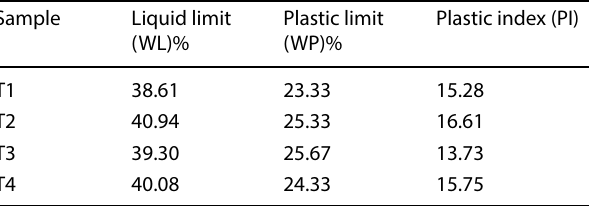
Table 3 Atterberg limits data of the different four samples Sample